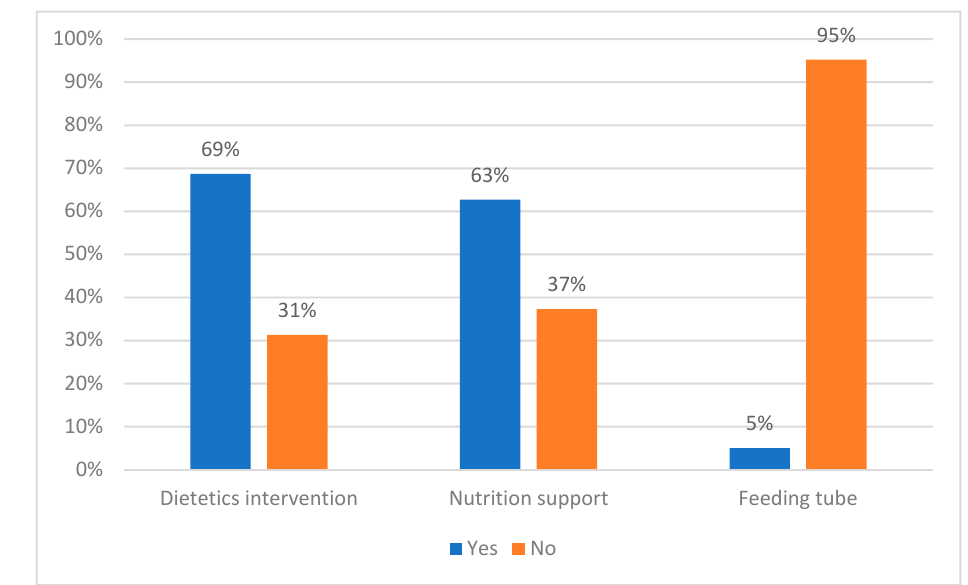
Figure 3. Malnourished participants ( n = 84): receipt of preoperative dietetics intervention, nutrition support, and feeding tube present on admission to surgery.